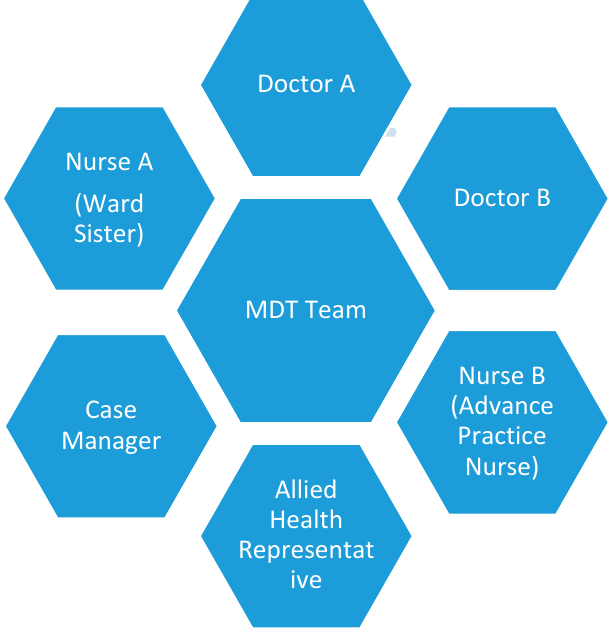
Figure 2. Multi-disciplinary (MDT) Team. Doctor A: Chair the discussion and oversee the control steps. Reports to higher management on the care plans. Nurse A: Oversees the screening of nurses and prophylactic treatments. Ensures the nurses adhere to contact precautions and hand hygiene.